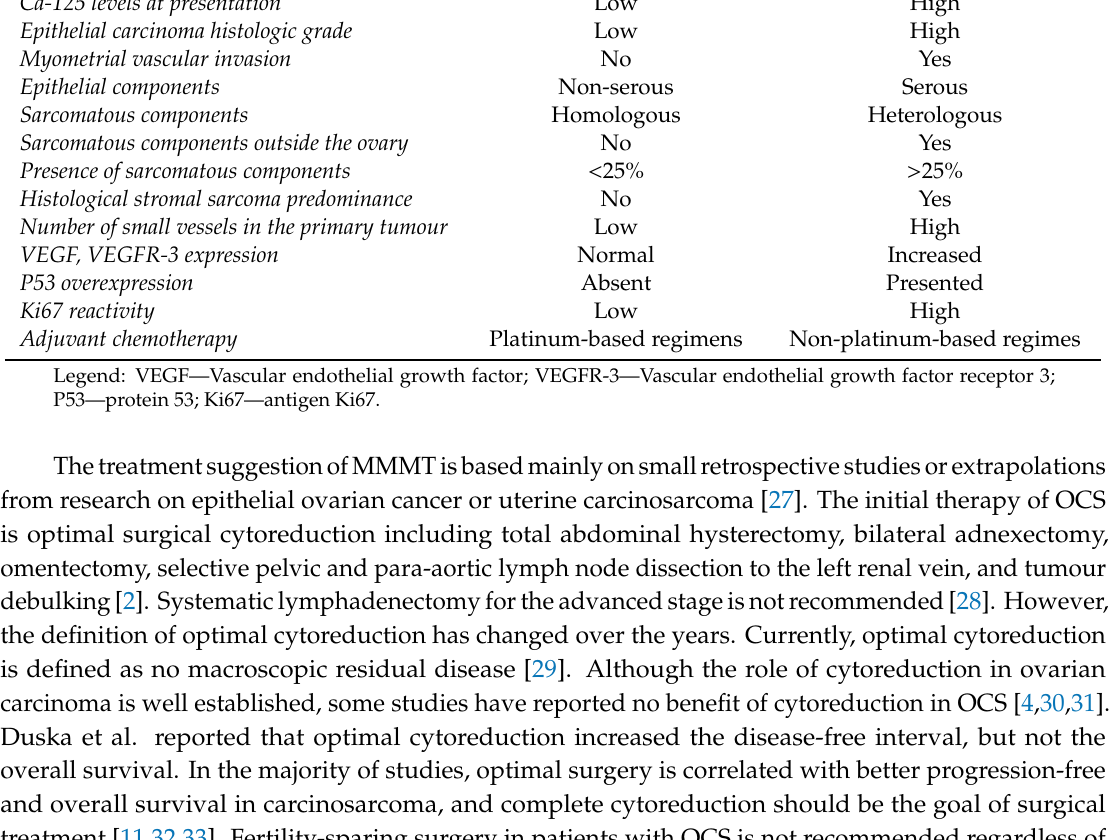
Table 1. Prognostic significance of various prognostic factors relevant to ovarian carcinosarcoma. Prognostic Factors Favourable Unfavourable Patient’s age < 65 years > 65 years Initial tumour stage Early Advanced Surgery Optimal surgical resection Suboptimal surgical resection Ca-125 levels at presentation Low High Epithelial carcinoma histologic grade Low High Myometrial vascular invasion No Yes Epithelial components Non-serous Serous Sarcomatous components Homologous Heterologous No Yes Presence of sarcomatous components < 25% > 25% Histological stromal sarcoma predominance No Yes Number of small vessels in the primary tumour Low High VEGF, VEGFR-3 expression Normal Increased P53 overexpression Absent Presented Ki67 reactivity Low High Adjuvant chemotherapy Platinum-based regimens Non-platinum-based